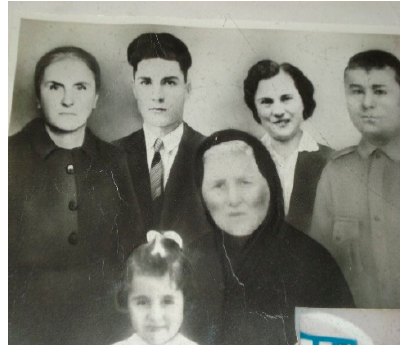
Figure 3. Fyllio’s collaged family photo (author’s collection).